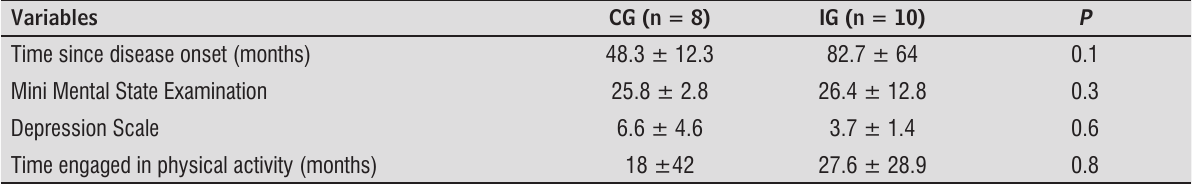
Table 1 - Pre-intervention demographic, anthropometric and clinical